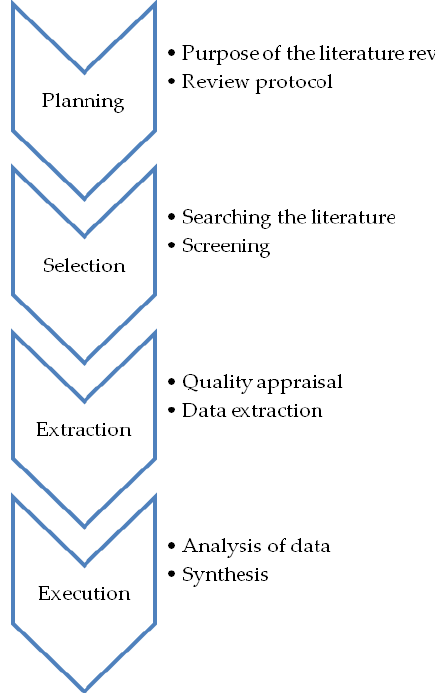
Figure 1. A systematic literature review guide [14].